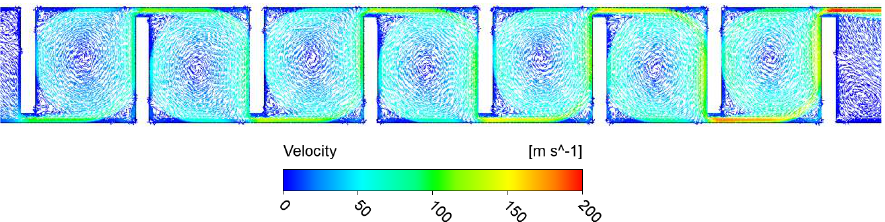
Figure 1. Example vectors of velocity fields in a representative segment for p in /p out = 2 and 𝑇 𝑖𝑛 = 300 K , 𝑝 𝑜𝑢𝑡 = 10 5 Pa .